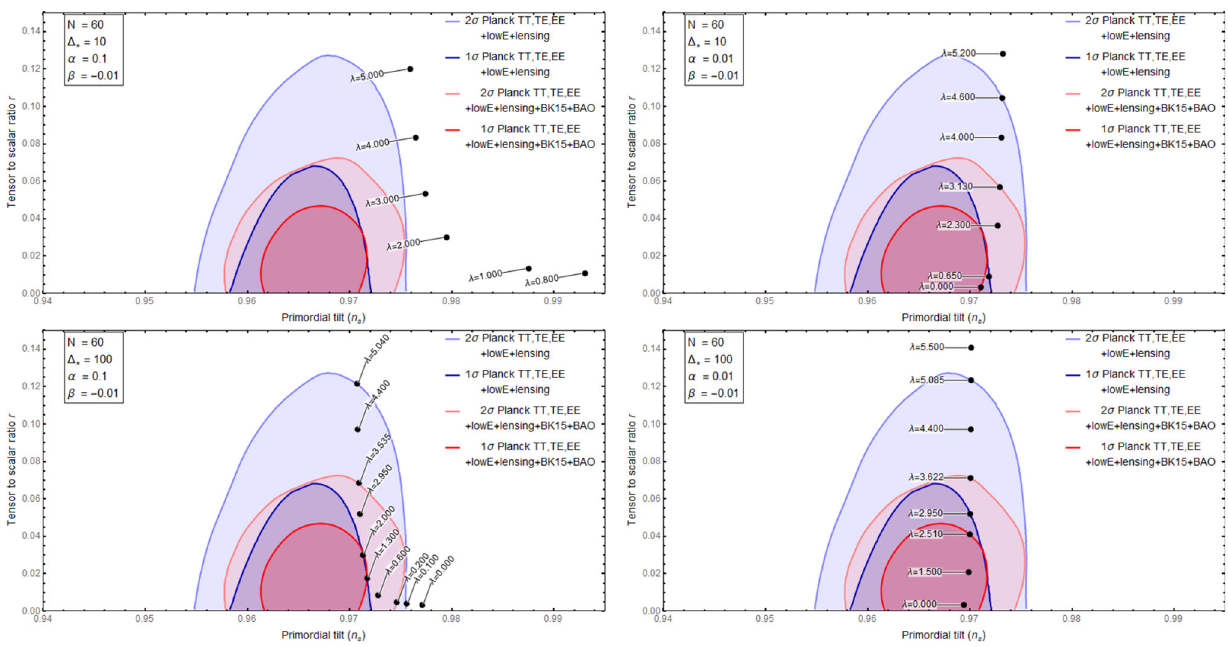
− 0 . 01 , N = 60 (lower-left panel) and (cid:23) (cid:25) = 100 , α = 0 . 01 , β = − 0 . 01 , N = 60 (lower-right panel) with Planck’18 results for TT, TE, EE, +lowE+lensing and +BK15+BAO